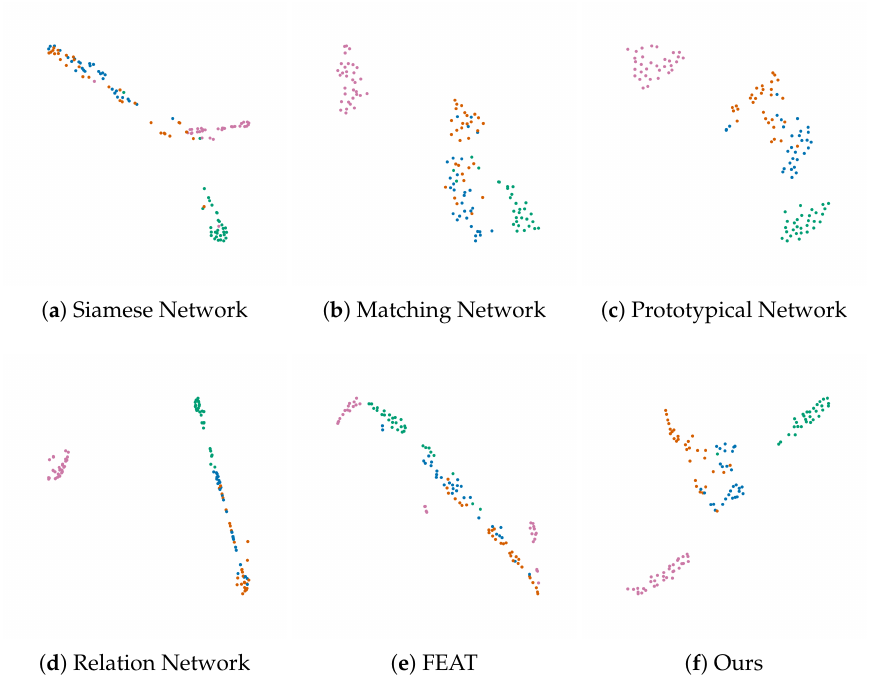
Figure 11. The visualization result of different methods on the VA dataset under the “4-way 1-shot” condition, where ( a – e ) denote different comparison methods and ( f ) denotes our proposed